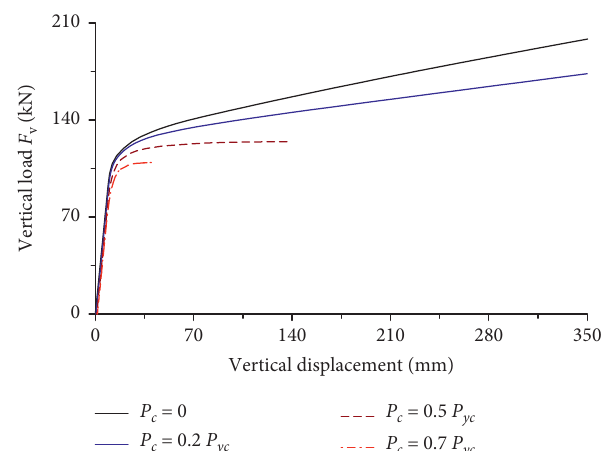
Figure 6: Load to vertical displacement curves for various con- ditions of column compression. Figure 7: Deformation of the beam-column connection ( P